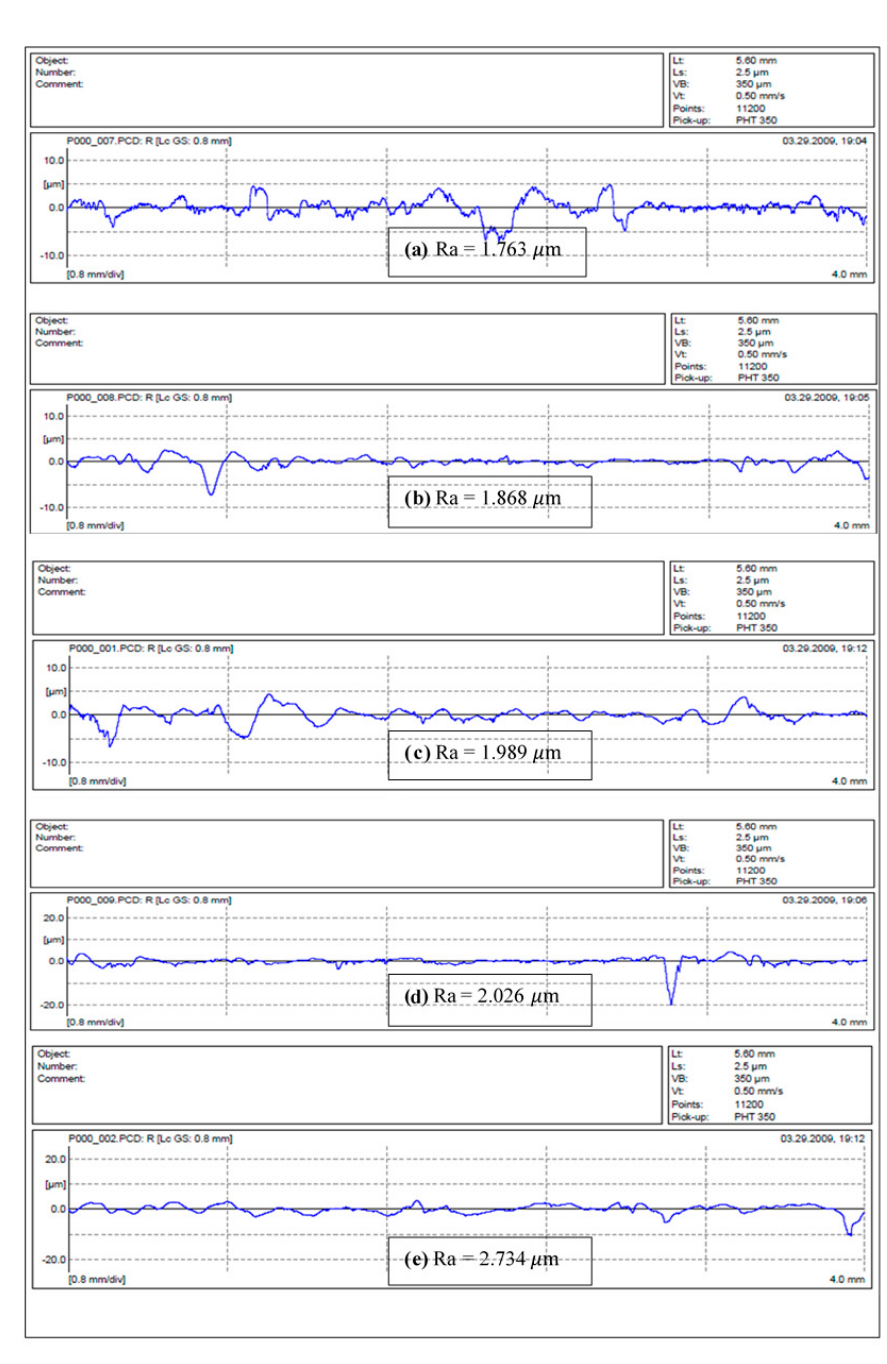
Figure 11. Roughness values of NE samples. Note: SV—Sliding Velocity; AL—Applied